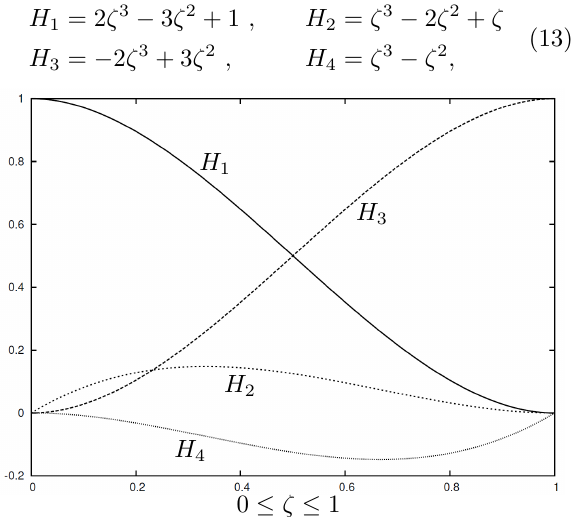
Figure 3. Four Hermite polynoms per element